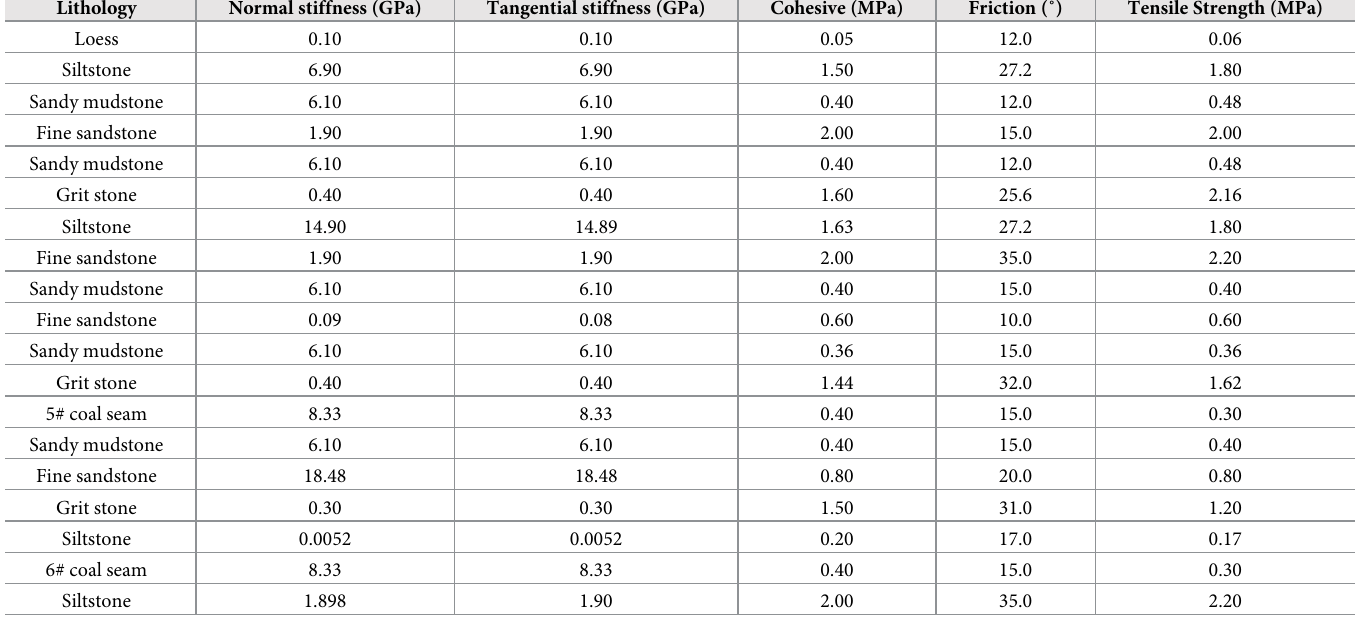
Table 4. Mechanical parameters of the coal and rock joint